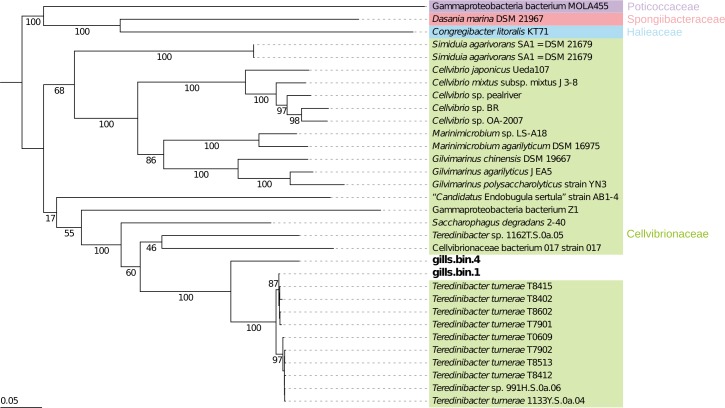
Phylogeny of two high quality Teredinibacter bins based on a concatenated alignment of 43 proteins.RAxML maximum likelihood tree based on the CAT model of rate heterogeneity and LG amino acid substitution matrix, with 100 rapid bootstraps. To improve readability, bootstraps for the Teredinibacter turnerae sub-clades I and II (with bootstrap values of 87 and 97 respectively) are omitted. The tree is rooted in between the Cellvibrionaceae branch and representatives of Halieaceae, Porticoccaceae, and Spongiibacteraceae. Color-coding of the families is similar to the one used by Spring and co-authors (2015). The scale bar represents 0.05 nucleotide substitutions per site.